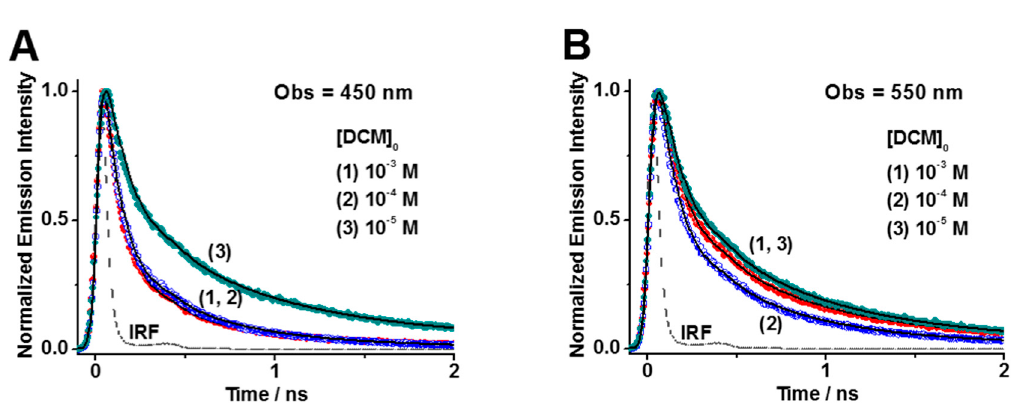
Figure 3. ( A , B ): Normalized (to the maximum of intensity) magic-angle emission decays of DCM@HY in dichloromethane suspensions upon excitation at 371 nm and observing at ( A ) 450 and ( B ) 550 nm at three different initial dye concentrations (1 × 10 − 3 , 1 × 10 − 4 , and 1 × 10 − 5 M). The solid lines are from the best multi-exponential fits to the experimental data. The instrument response function (IRF) is ~ 70 ps.